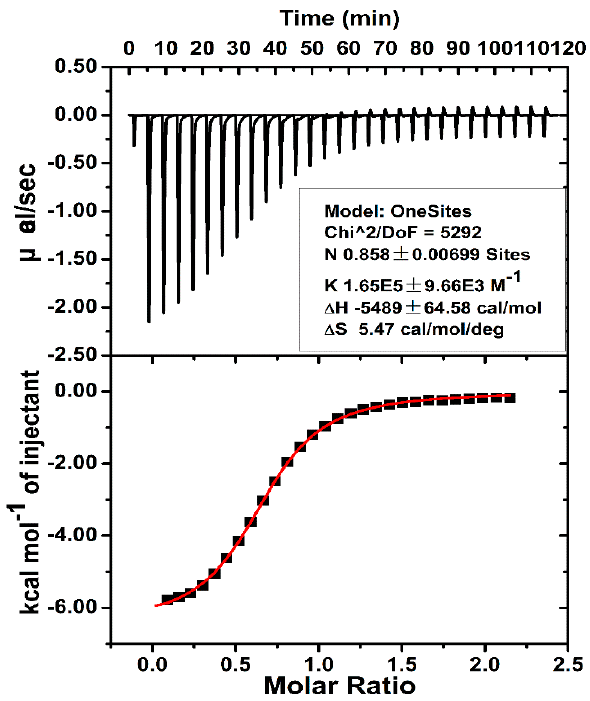
Figure 2. ITC results for the host-guest complexation of CB[7] with mPEG-b-QP4VP in an aqueous solution at 298 K.